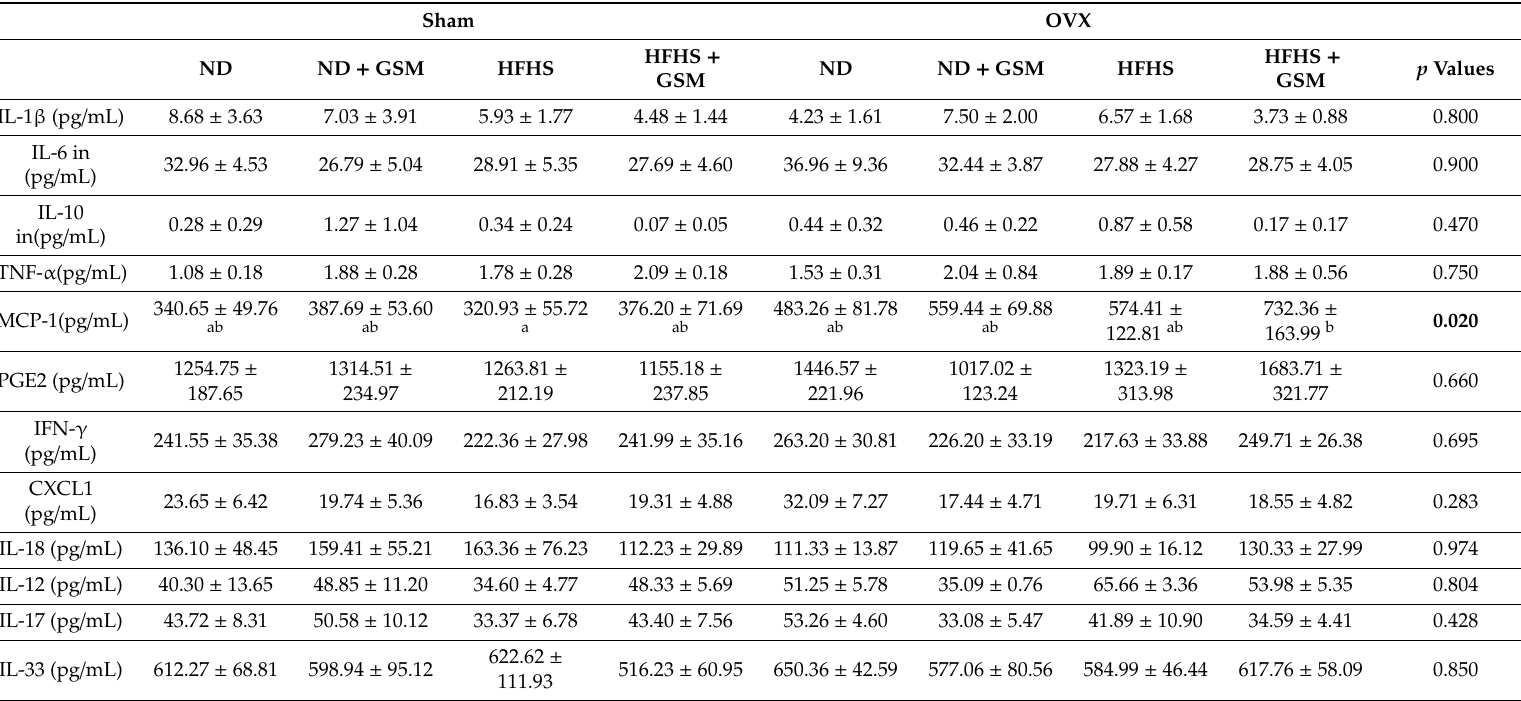
Table A2. Analysis of inflammatory markers in systemic